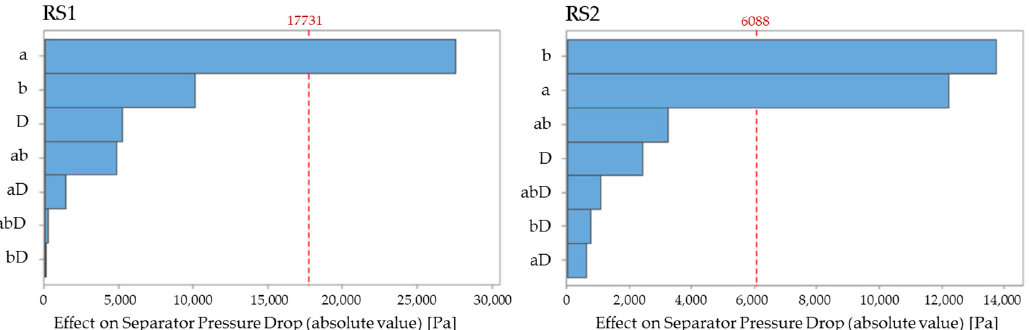
Figure 7. Pareto chart for the separation efficiency for both DOE variants.